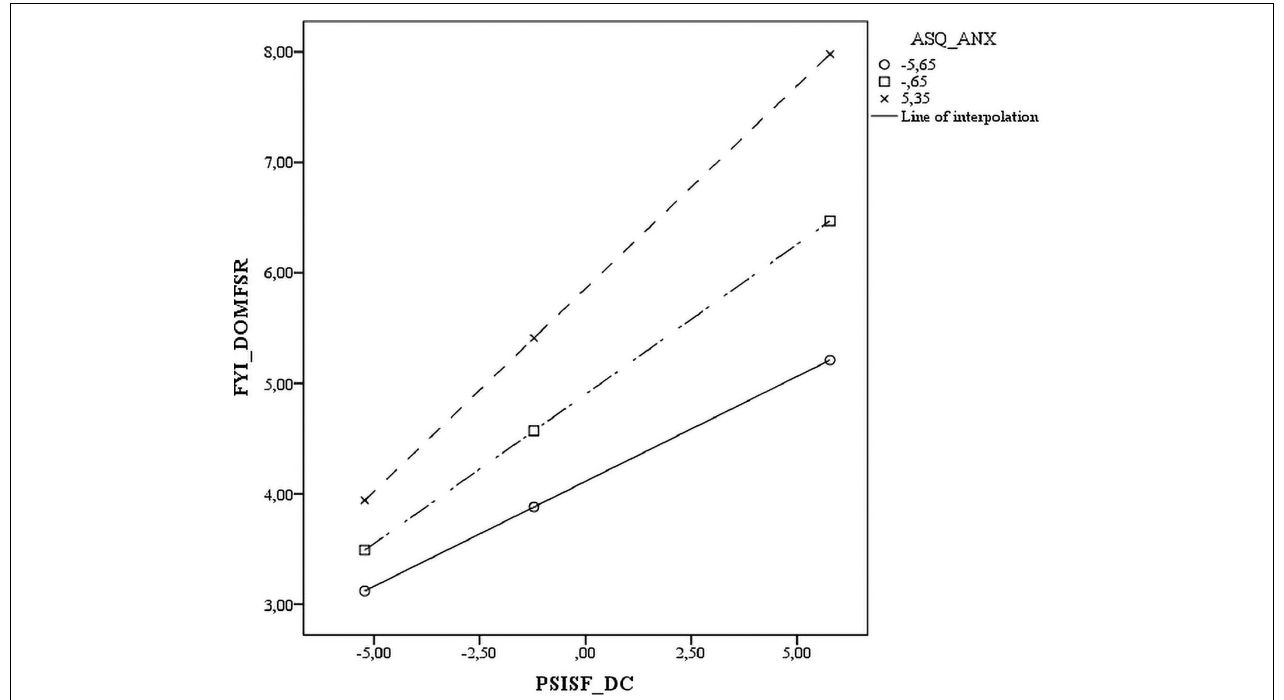
FIGURE 3 | Scatter plot of the interaction between anxious attachment style and difficult child on the sensory regulation domain.